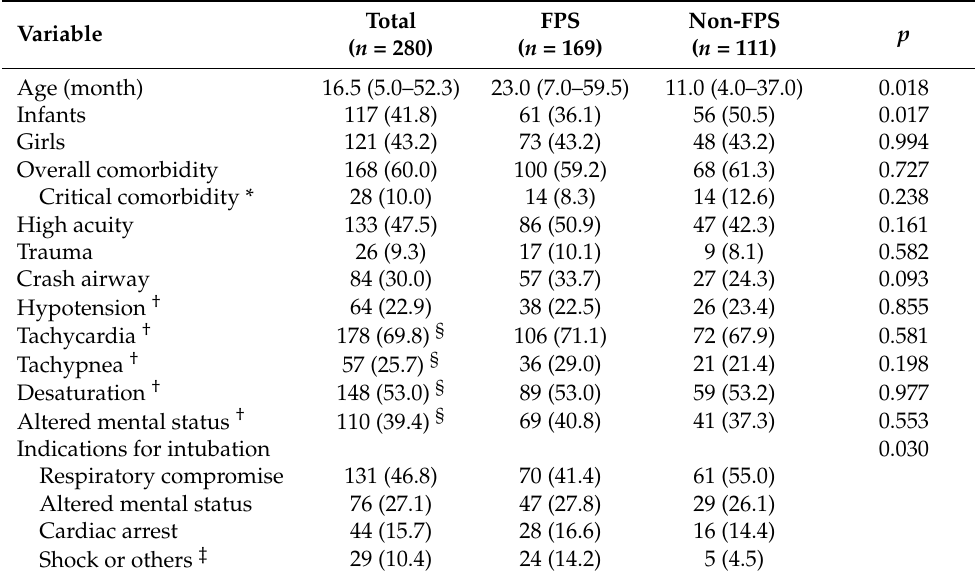
Table S2 [14]. ‡ Only one 13-month-old febrile boy with pneumomediastinum was intubated at an intensive care unit to prepare endoscopy and later demonstrated a laryngeal injury. § The denominators are 255, 222, 279, and 279 in the order of rows. FPS indicates first-pass